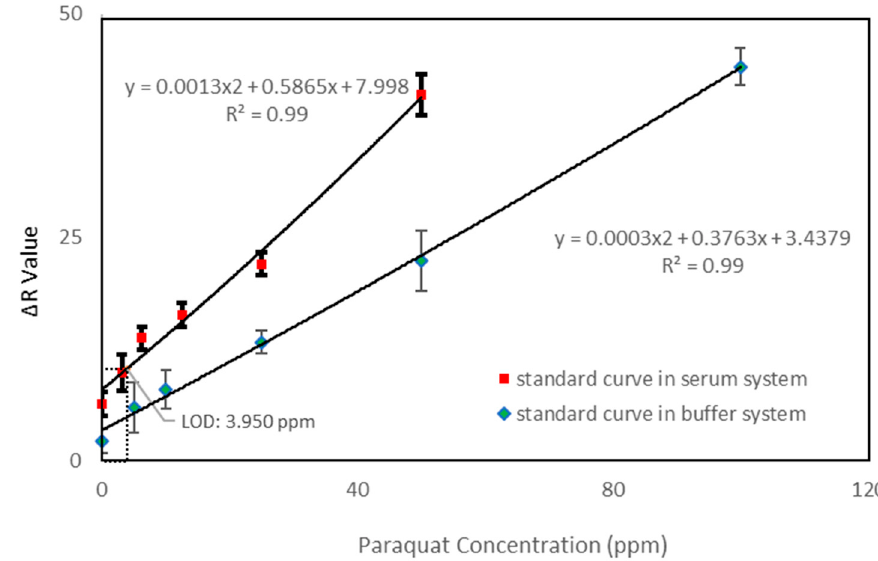
Figure 3. Paraquat standard curve (n = 8, N = 3). Green indicates the standard curve in a buffer system, with a concentration range of 0–100 ppm; red indicates the standard curve in a serum system, with a concentration range of 0–50 ppm. Correlation coefficient (R 2 ) of standard curves in both buffer and serum systems equals 0.99.